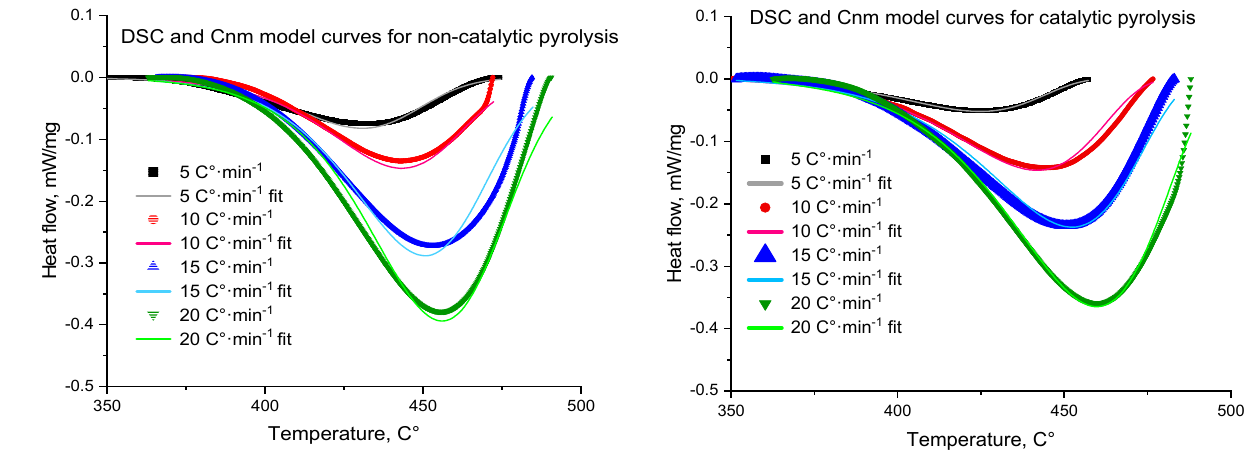
Figure 4. Correlation between experimental DSC curves obtained for extra-heavy oil pyrolysis process and the fit DSC curves for this process based on a model corresponding to n-order autocatalysis reaction with m-power by-product (Cnm) in the presence and the absence of iron tallates.